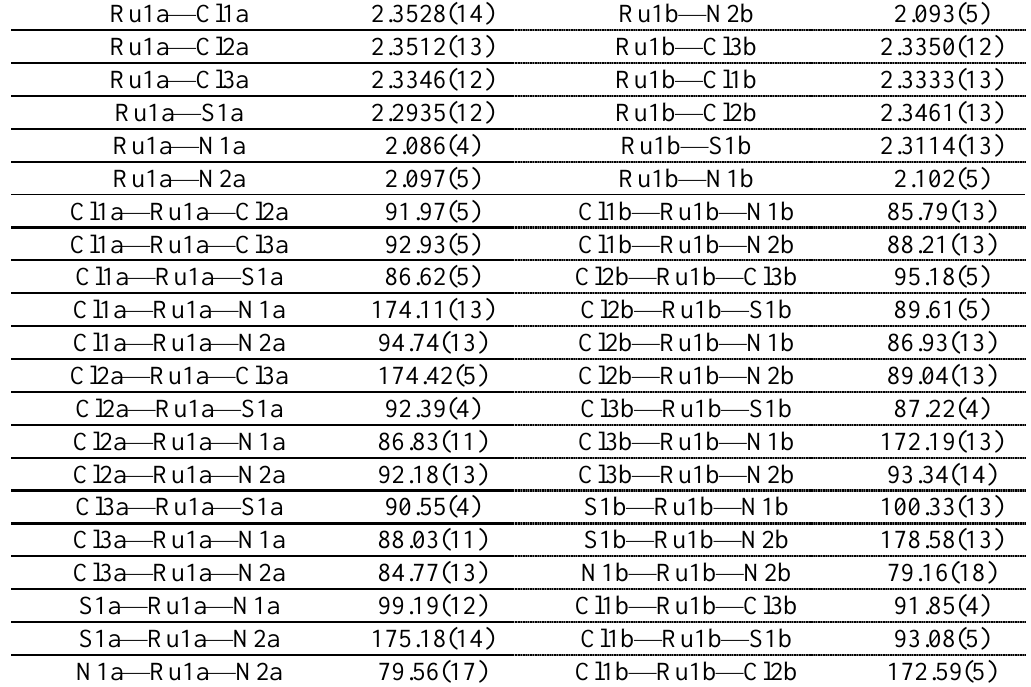
Table S2 : Selected geometric parameters (Å, °) in 1